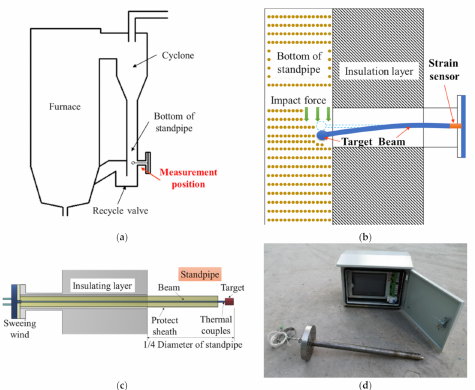
Figure 4. G s measurement system in an industrial CFB boiler; ( a ) Measurement position; ( b ) Measur- ing principle; ( c ) Diagram of measurement device; ( d ) Picture of read